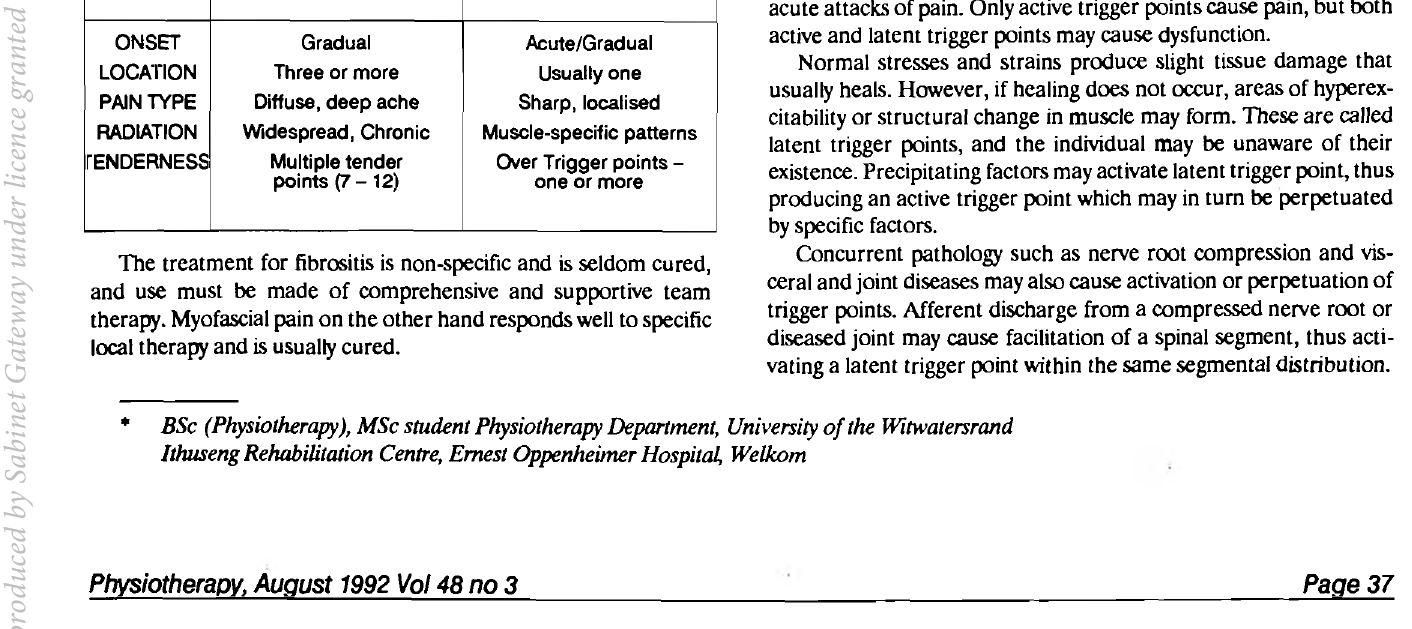
TABLE II: CHARACTERISTICS OF